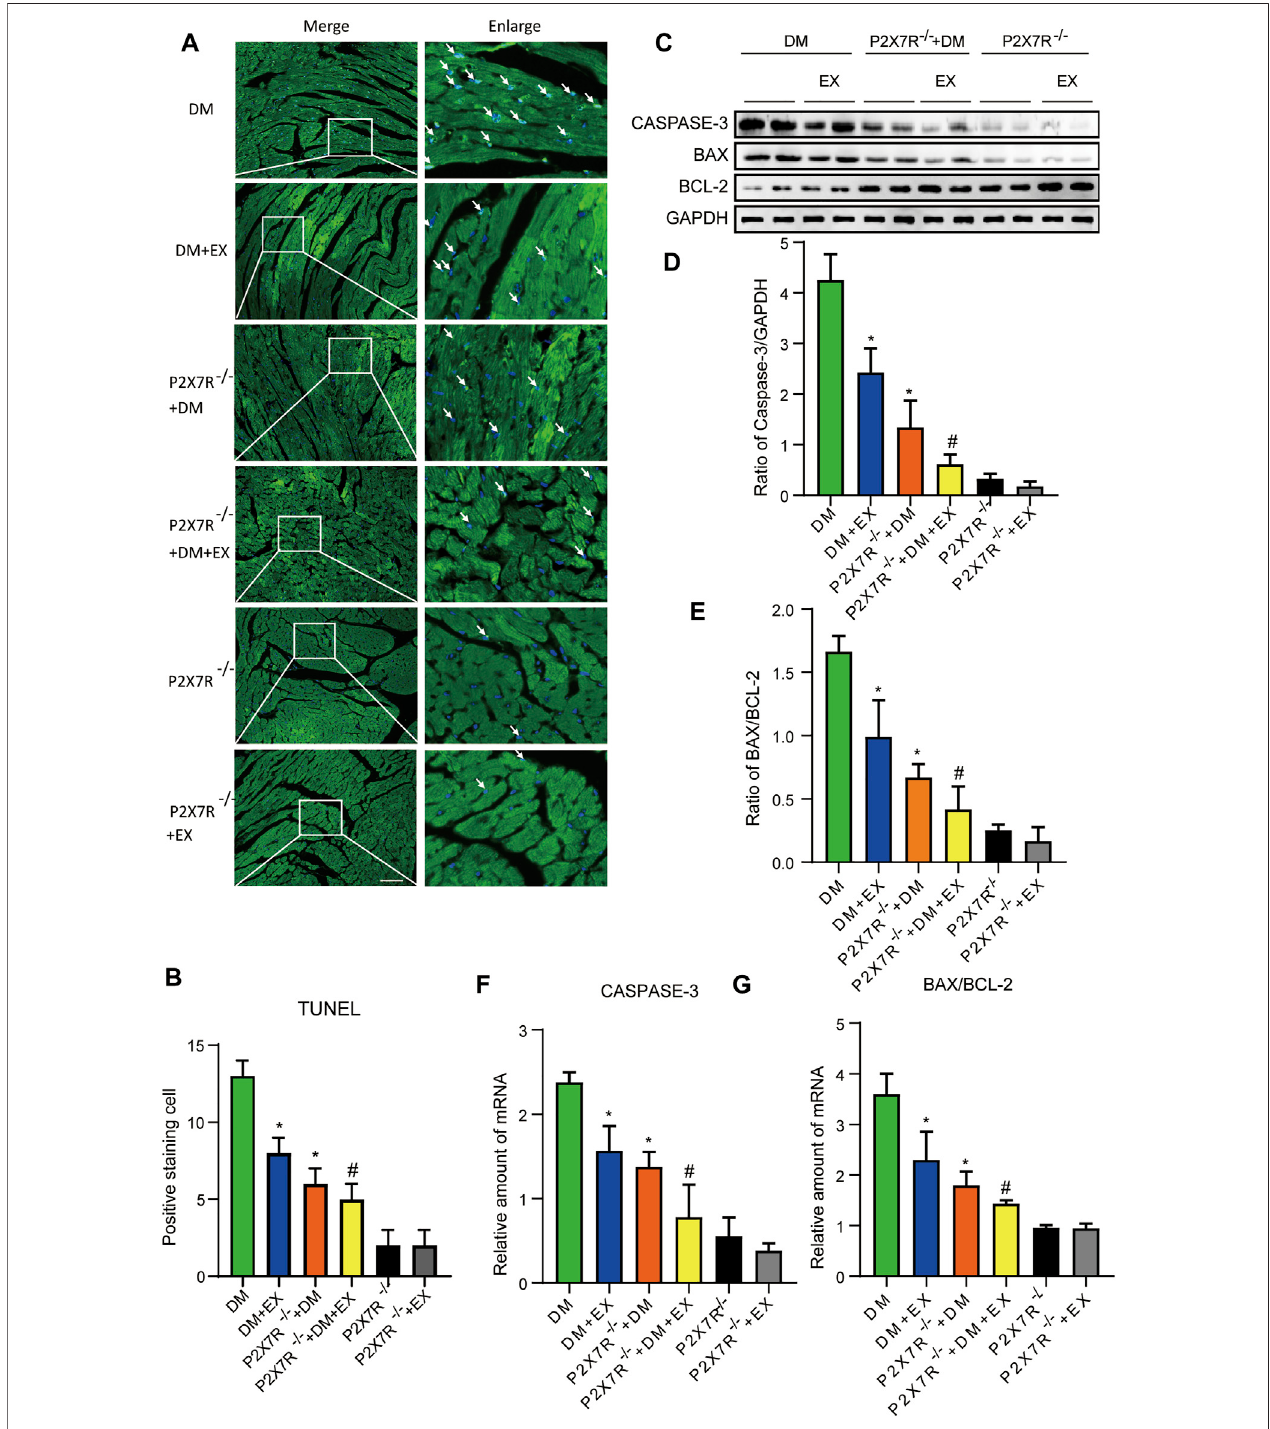
FIGURE 11 | P2X7R knockout or exercise training had positive effects on reducing myocardial apoptosis. (A,B) The images and quantitative statistics of TUNEL stainingforapoptosisofmyocardialcellsindiabeticmice. (C – G) Statisticalmapofproteinandgeneexpressionofapoptosis-relatedprotein(Caspase-3,Bax,andBcl-2) in myocardial tissues were measured using Western blotting and PCR. * p < 0.05 vs. the DM group, # p < 0.05 vs. the DM + EX group.